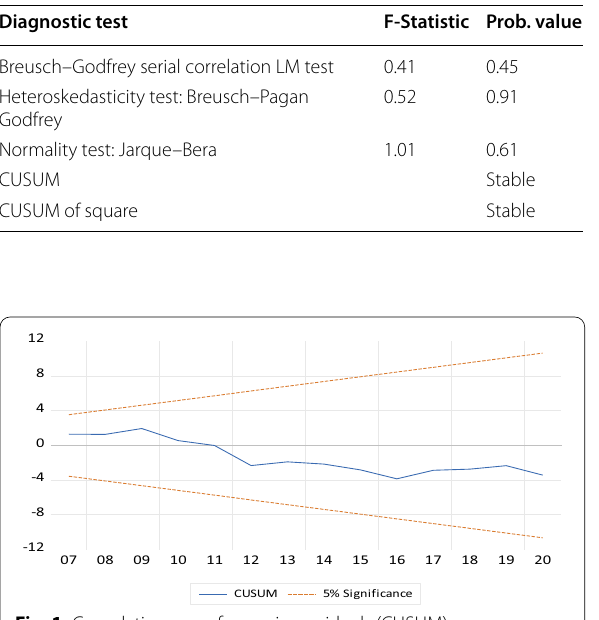
Fig. 1 Cumulative sum of recursive residuals (CUSUM)